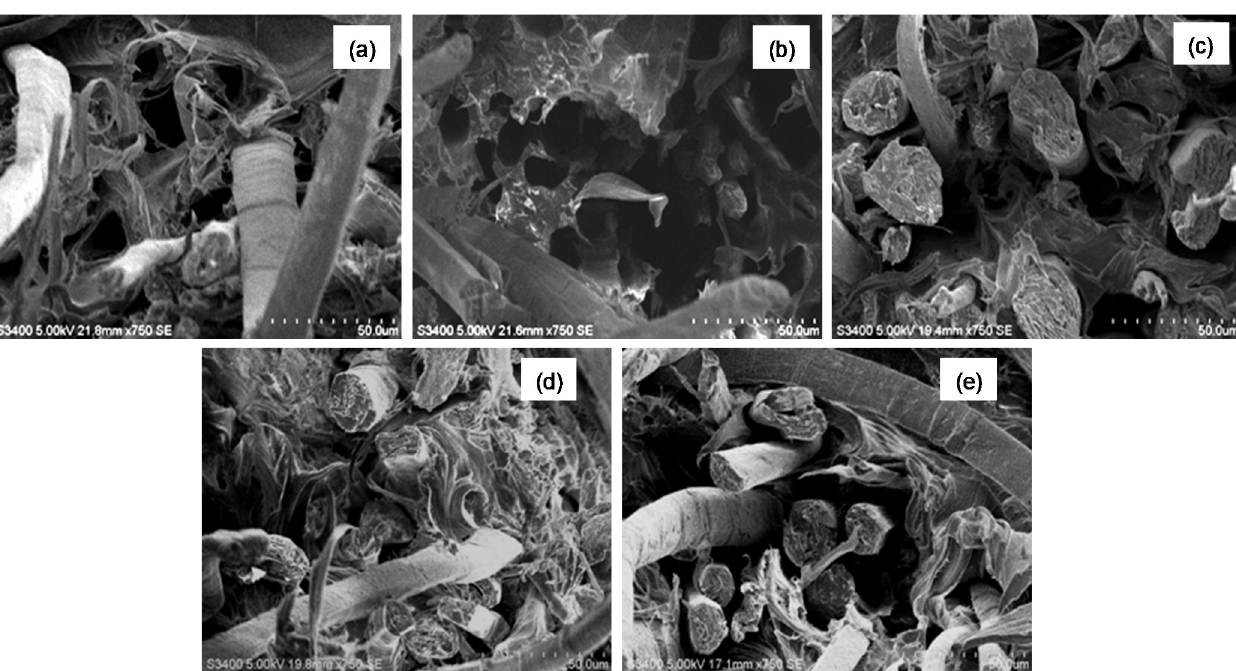
Figure 9. SEM images of the fractured regions of ( a ) Flax/PP, ( b ) FR-Flax-PP, ( c ) FR-Si-Flax/PP, ( d ) FR-Pm-Flax/PP, and ( e ) FR-Pm-Si-Flax/PP 8-layered laminates. ( d ) FR-Pm-Flax/PP, and ( e ) FR-Pm-Si-Flax/PP 8-layered